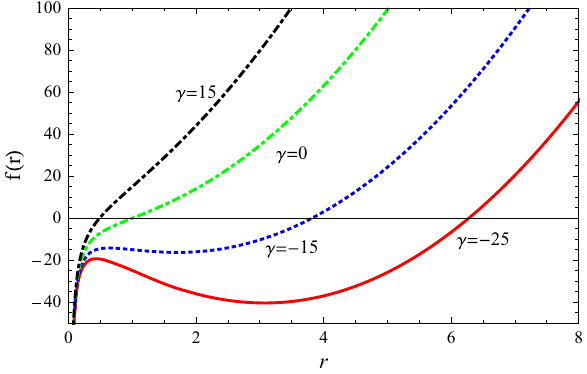
Fig. 2 The behaviour of metric function f ( r ) plotted against radial coordinate r with differing γ . For demonstration, we fix α 2 m = 4 , M = 1 ,α g = 1 ,(cid:14) =